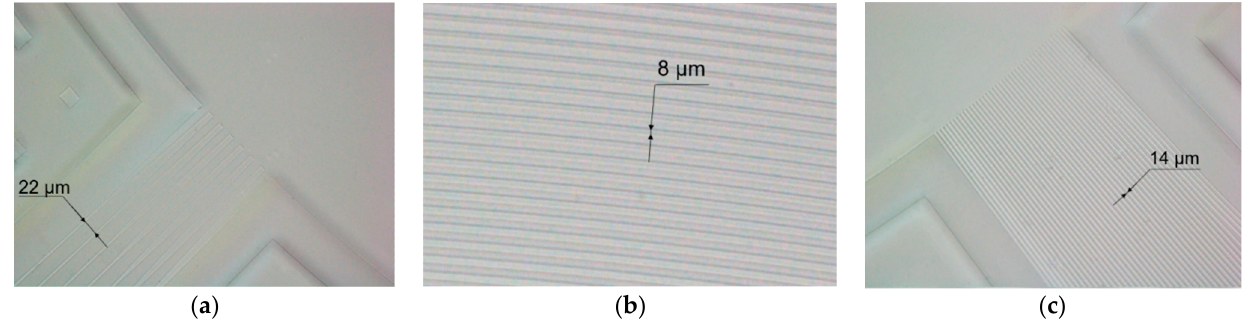
Figure 8. Microscope photo of ( a ) input waveguides; ( b ) arrayed waveguides; ( c ) output wave- guides.